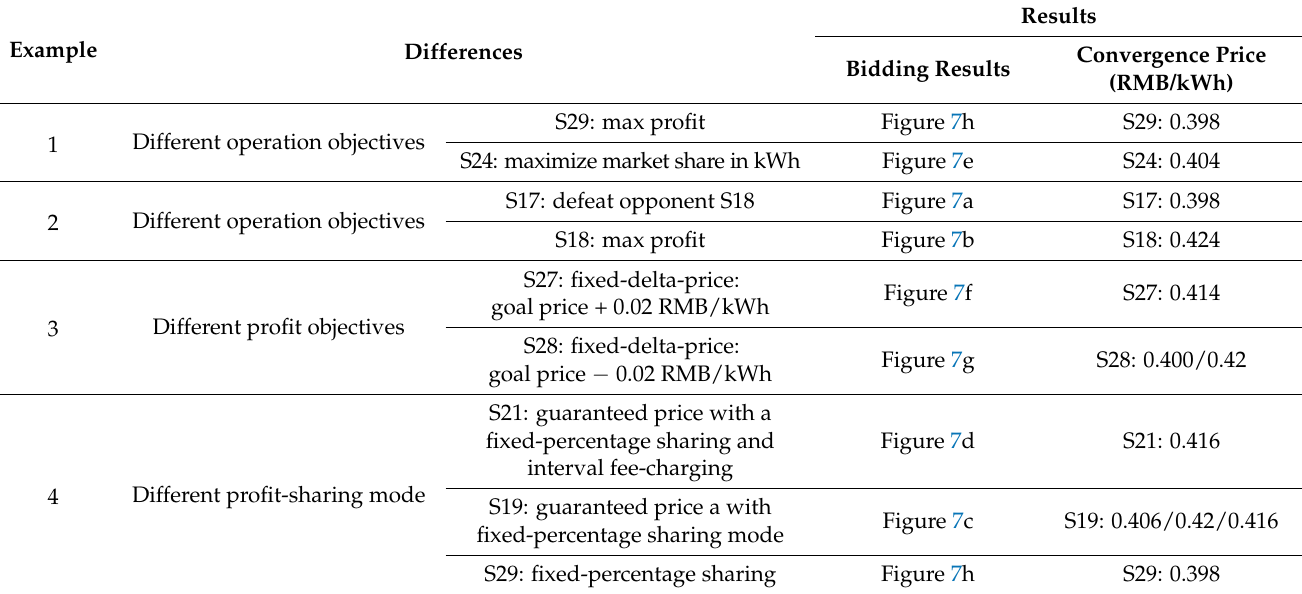
Table 2. Overview of the comparison-in-pair of diverse bidding